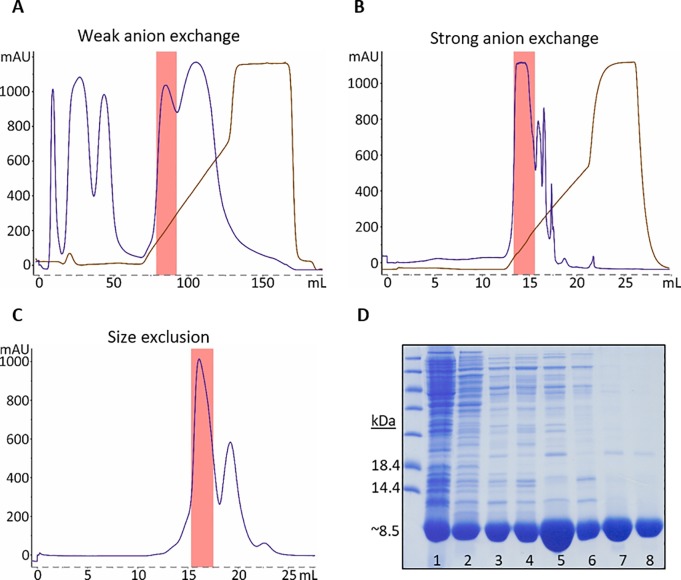
Purification of HA tri-stalk protein.Chromatography profiles of protein fractionation on DEAE FF (A), MonoQ (B) and Superdex (C) columns. Blue lines represent protein peaks while brown lines correspond to salt gradient. HA tri-stalk containing fractions are marked by red squares. (D) Coomassie-stained PAAG illustrating individual purification steps: 1 and 2, supernatant before and after thermal treatment, respectively; 3–4, DEAE column fractions; 5–6, MonoQ column fractions; 7–8, Superdex column fractions.